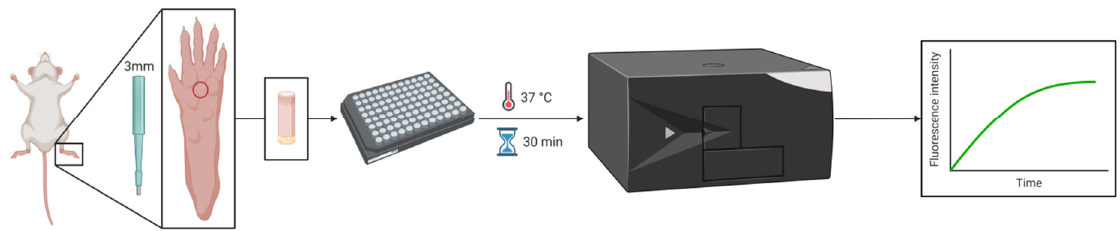
Figure 1. Thrombin activity in rodent skin-method flow diagram: for measuring thrombin activity in rodent skin, a 3 mm punch was obtained from the hind paw, placed in a 96-well black plate, and incubated at 37 °C for 30 min. Following the incubation, a specific thrombin substrate was added, and the fluorescence intensity over time was measured. Created with BioRender.com (accessed on 25 November 2021).